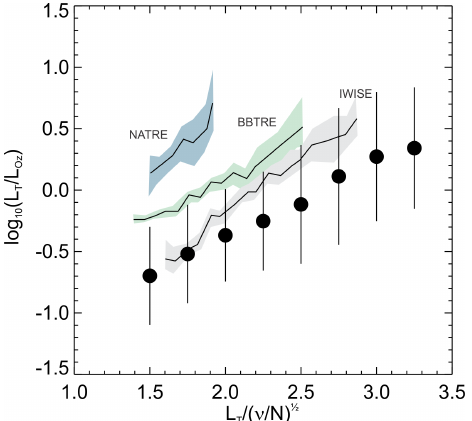
Figure 12. The comparison of the L T /L Oz ratio as a function on non-dimensionalized L T . The present dataset (circles with ± 1 × standard deviation as error bars) is superposed on top of synthesized results following Mater et al.